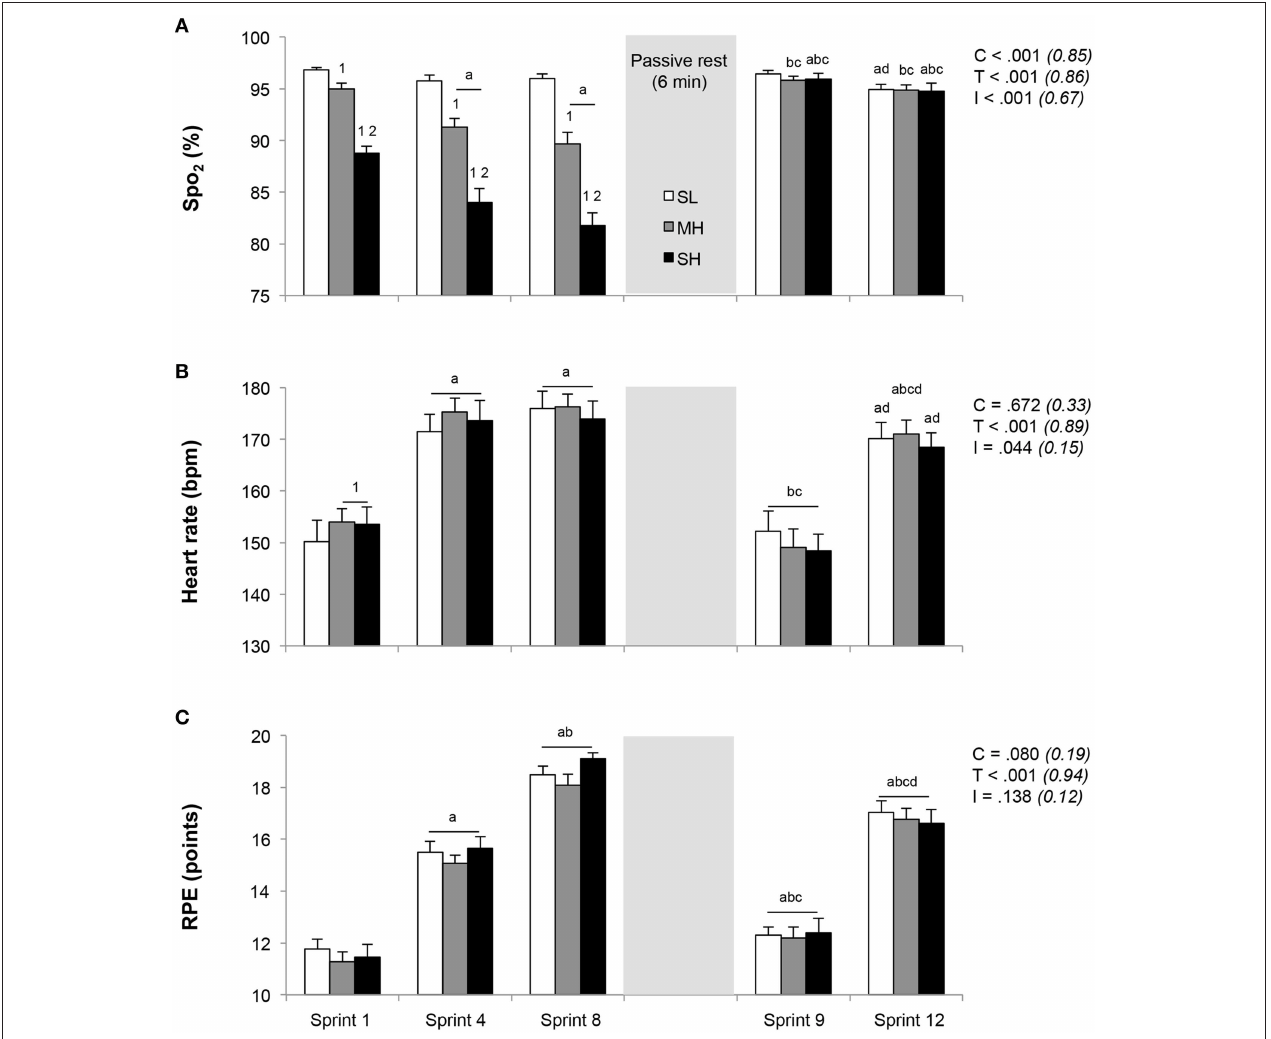
FIGURE 1 | Changes in exercise responses (A, SpO 2 ; B, heart rate; C, RPE). Mean ± SD ( n = 13 ). The repeated-sprint exercise protocol included a first set of eight sprints performed at sea level (SL), moderate (MH), or severe hypoxia (SH), while the second set of four sprints was always performed at SL. SpO 2 , arterial oxygen saturation (estimated by pulse oxymetry); RPE, rating of perceived exertion. C, T, and I, respectively refer to ANOVA main effects of condition, time, and interaction between these two factors with P -value and partial eta-squared into brackets. a , b , c , and d significantly different from sprint 1, 4, 8, and 9, respectively ( P < 0.05 ). 1 and 2 significantly different from SL and MH, respectively ( P < 0.05 ).